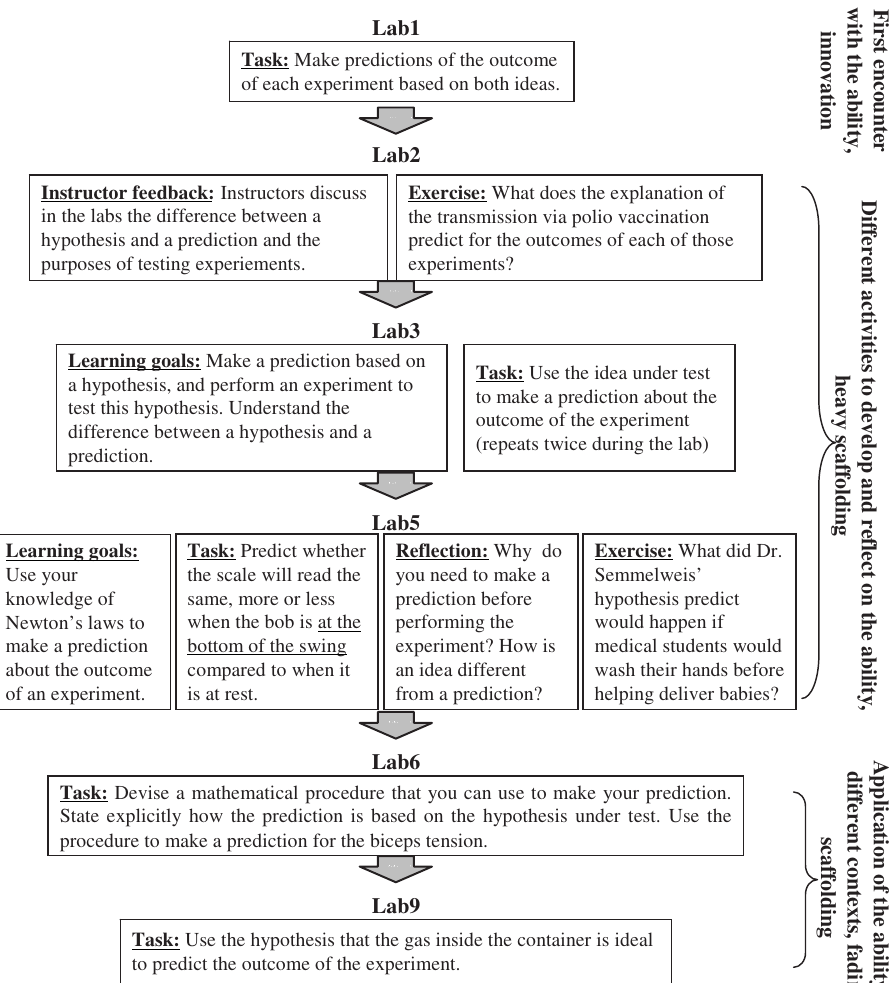
FIG. 1. A sequence of exer- cises to develop the abilities (cid:1) a (cid:2) to distinguish between a hypothesis and a prediction and (cid:1) b (cid:2) to make a prediction of the outcome of the experiment based on the